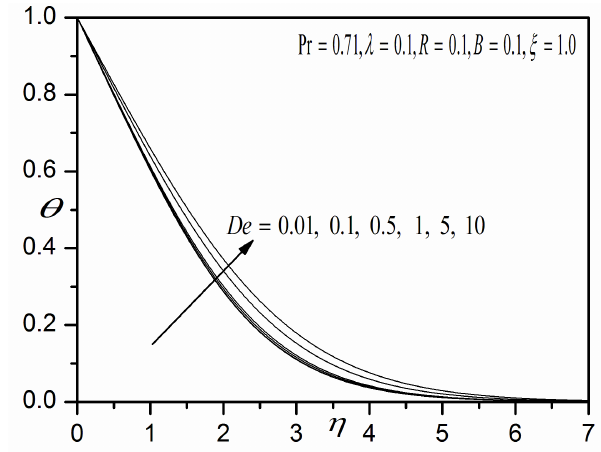
Fig. 3: Influence of De on the temperature.